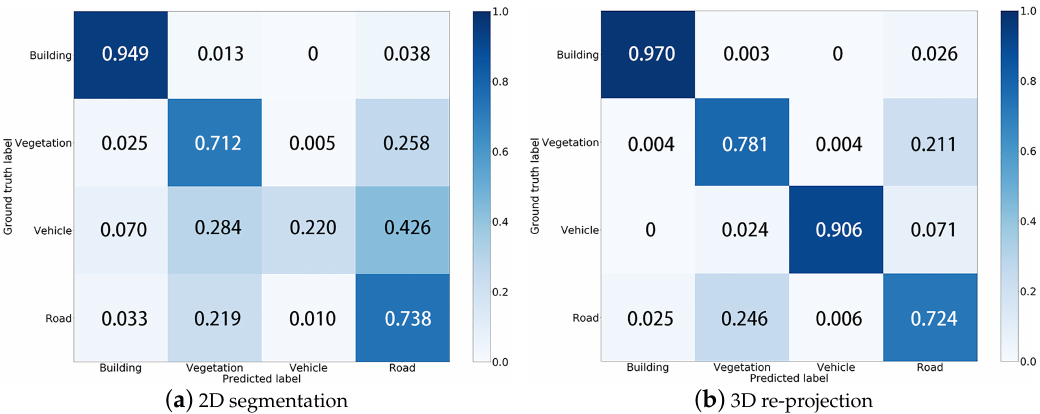
Figure 6. ( a ) is the Confusion Matrix for 2D segmentation, ( b ) is the Confusion Matrix for re-projection images. Four categories are evaluated, which are Building , Vegetation , Road and Vehicle . It shows that the re-projection map from 3D semantic points behaves higher accuracy compared with 2D segmentation, due to considering multi-view information.